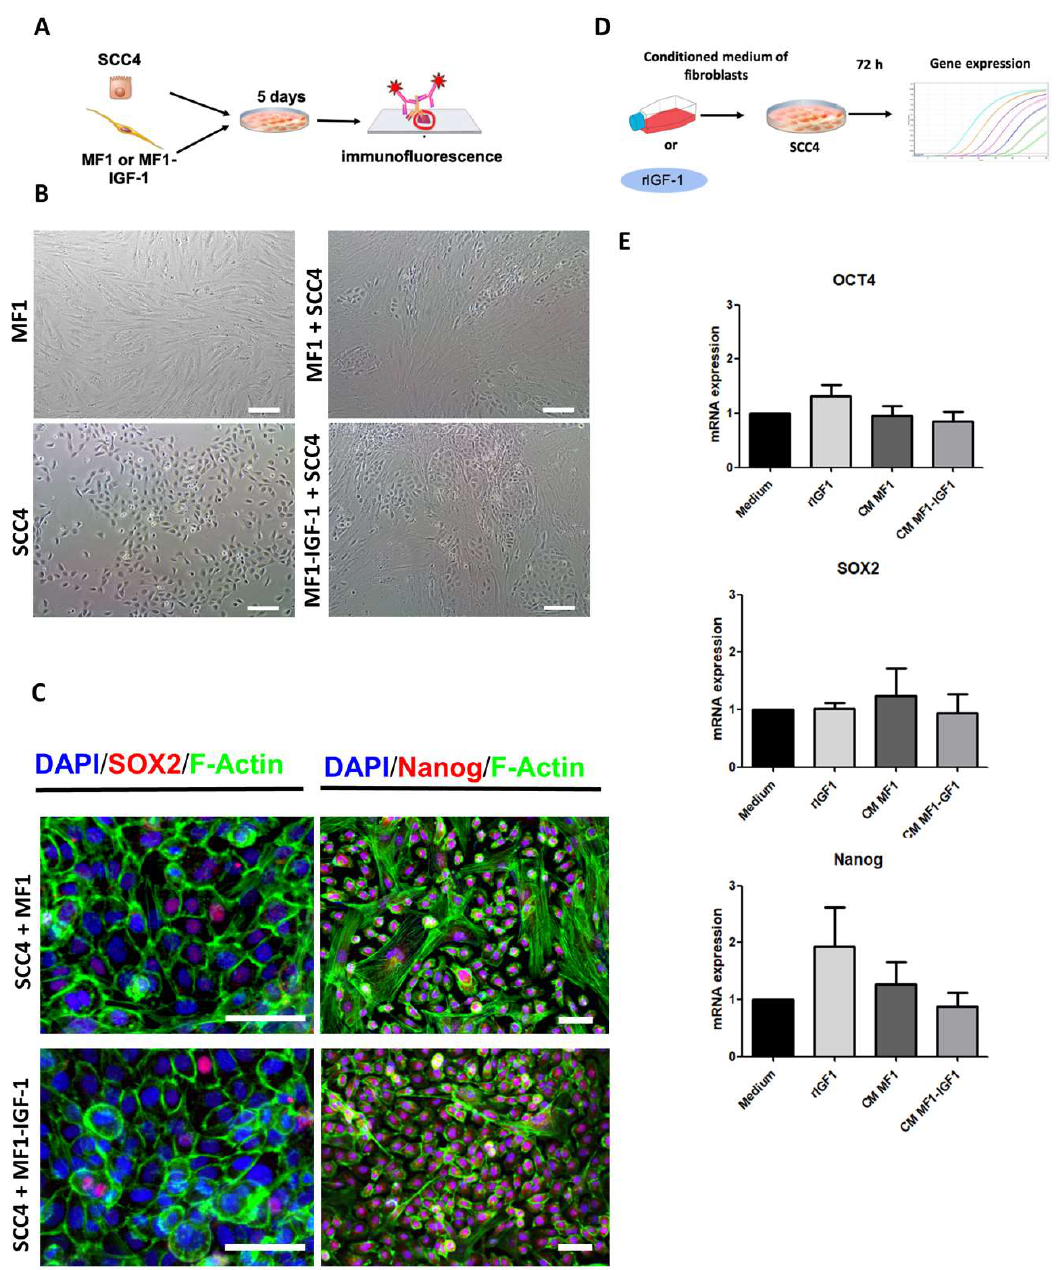
Figure 4. Evaluation of the expression of pluripotency markers in SCC-4. ( A ) Schematic design of the co-culture experiments. ( B ) Representative phase-contrast images of SCC-4/fibroblast co-culture. Bars = 100 μm. ( C ) Confocal microscopy images of cells stained for actin-F (green), pluripotency markers Sox-2 or Nanog (red) and nuclei stained with DAPI (blue). Differential cytoplasmic actin content and morphology allowed for the identification of fibroblasts as large cells with high expression of green fluorescence. Bars = 50 μm. ( D ) Schematic design of experiments evaluating pluripotency gene expression (OCT4, SOX2 and Nanog) by RT-qPCR following SCC-4 cell stimulation with control medium, rIGF-1, MF1-CM or MF1-IGF-1-CM for 72h. ( E ) Graphs detail the expression of each gene under different conditions. CM: conditioned medium.